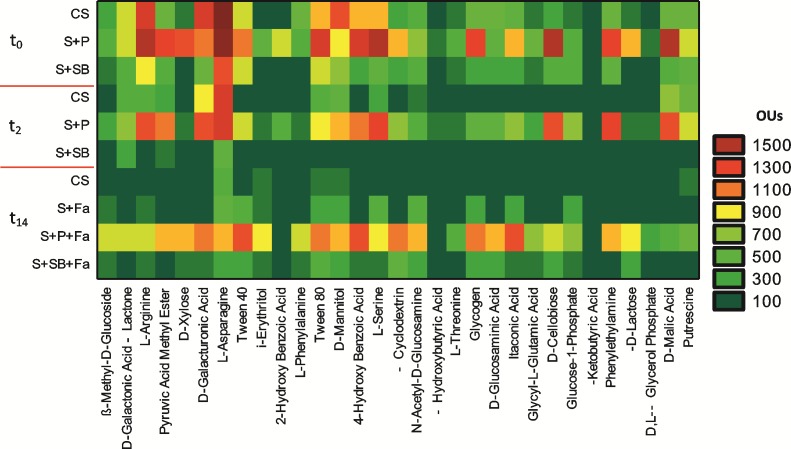
The activity of microorganisms in tested soils at t0—t14 (mean±SD; n = 3).The response of each compound was presented as a color scale ranging from dark green (0 OUs) to burgundy (1500 OUs).